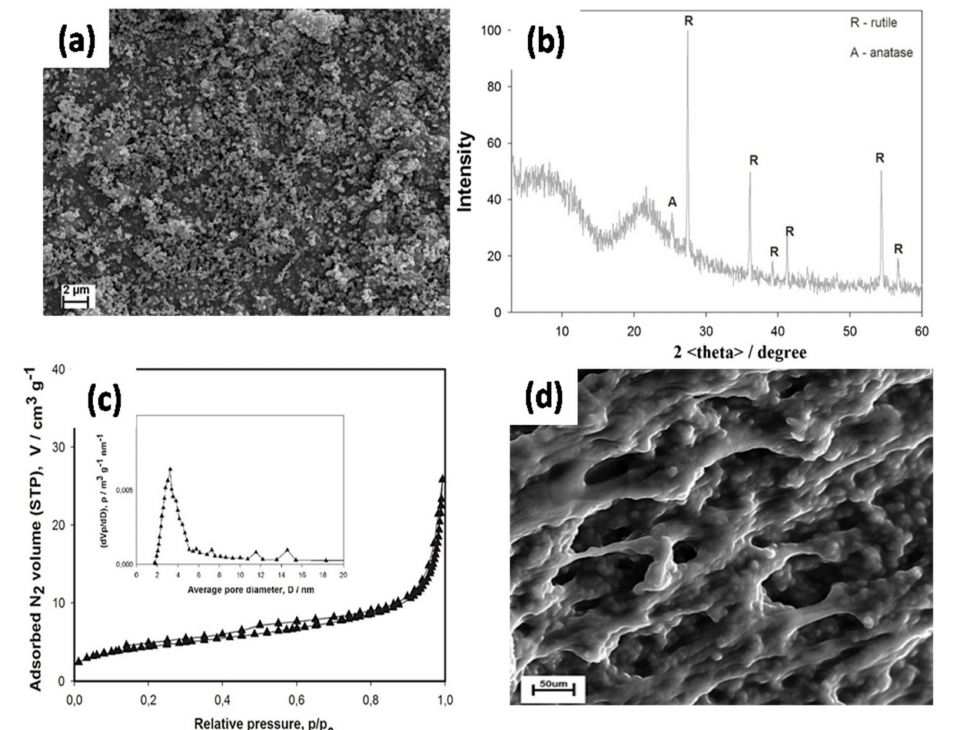
Figure 5. ( a ) SEM image of the TiO 2 -SiO 2 hybrid composite, ( b ) wide angle X-ray spectroscopy of the TiO 2 -SiO 2 hybrid composite, ( c ) nitrogen adsorption/desorption isotherm and pore size of the TiO 2 -SiO 2 hybrid composite, and ( d ) SEM image of the surface of the membrane containing the TiO 2 -SiO 2 hybrid composite. Reprinted with permission from Kurc et al. [81]. Copyright 2014 Elsevier